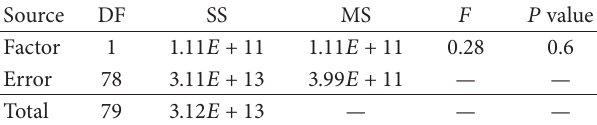
Table 9: The ANOVA analysis of the performances.